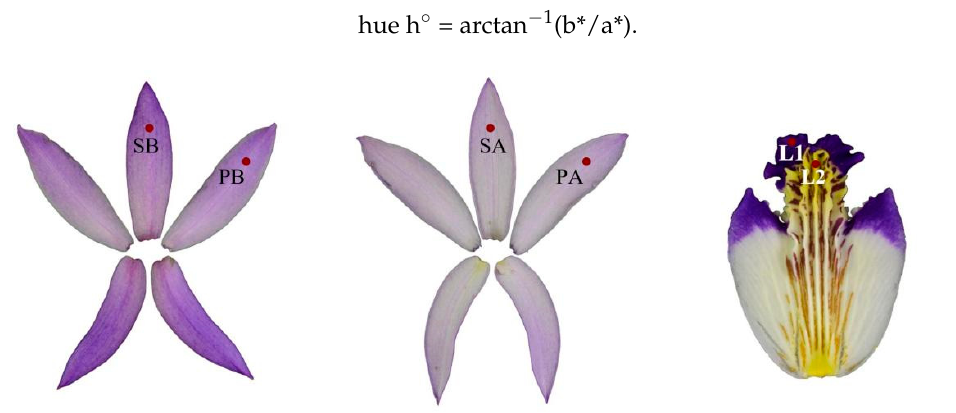
Figure 2. The illustration of Bletilla flower color measurement location (SB: sepal back, PB: petal back, SA: sepal front, PA: petal front, L1: Lip1, L2: Lip2).